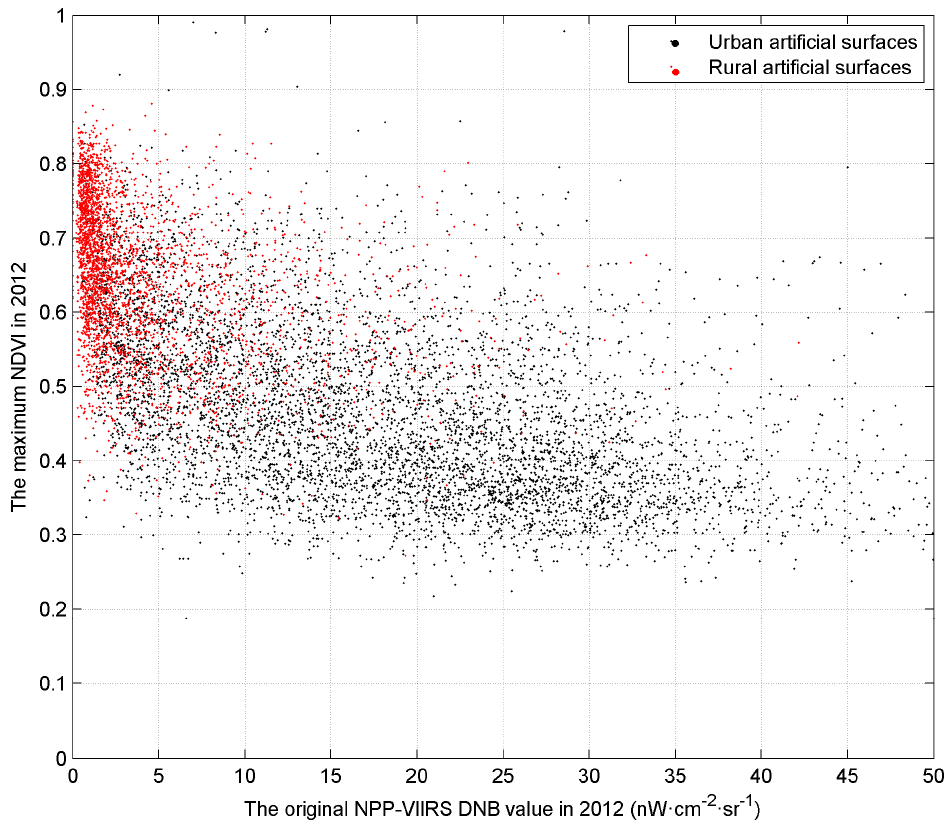
Figure 13. The distribution frequency of the NPP-VIIRS DNB value and the MODIS NDVI value of two types of artificial surfaces. The x -axis is the original NPP-VIIRS DNB value in 2012, and the y -axis is the maximum NDVI in 2012. Points with DNB values greater than 50 nW · cm − 2 · sr − 1 are not displayed.